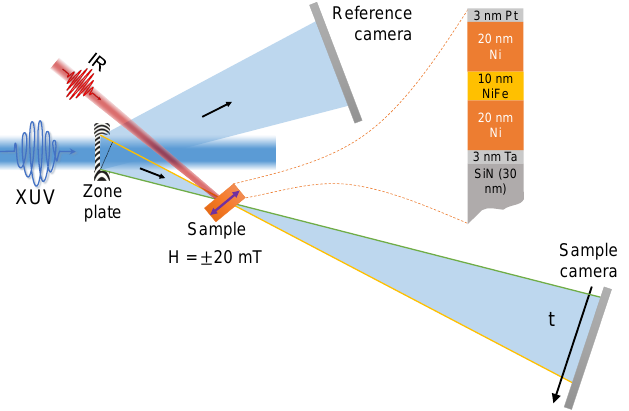
Figure 1. Experimental setup and sample composition. A circularly polarized extreme ultraviolet (XUV) beam is diffracted using a zone plate. The positive, first diffraction order is focused on an in-plane magnetized sample, which is pumped using linear infrared pulses. The sample camera records the intensity transmitted through the sample I , resulting in a spatial encoding of the time traces. The reference camera records the incident intensity I in